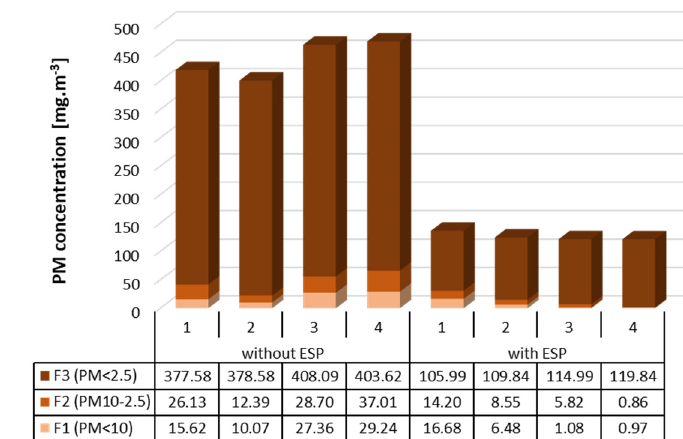
Figure 3. The concentrations of particulate matter.